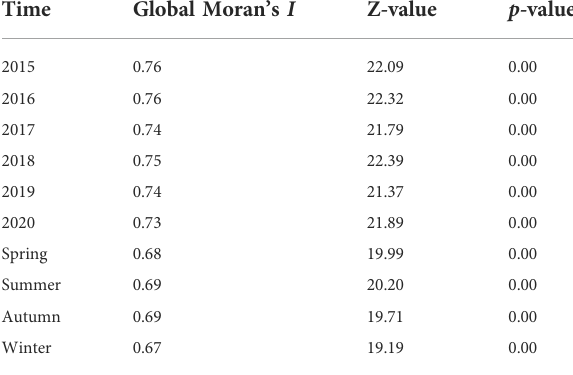
TABLE 2 Global Moran ’ s I and its test